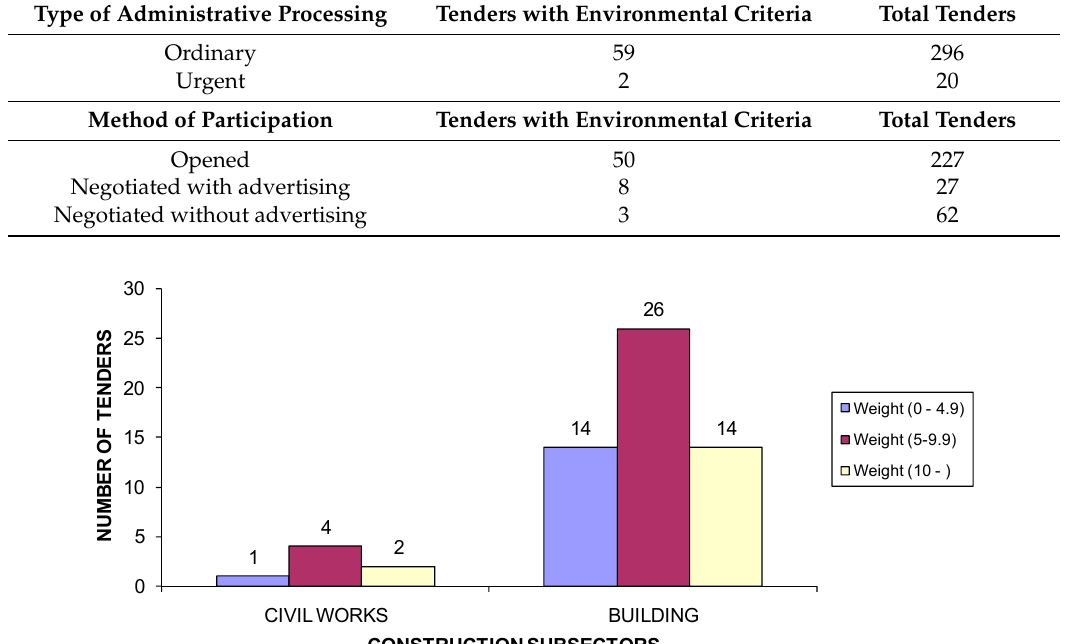
Table 5. Environmental criteria according to the type of administrative processing and participation approach. Type of Administrative Processing